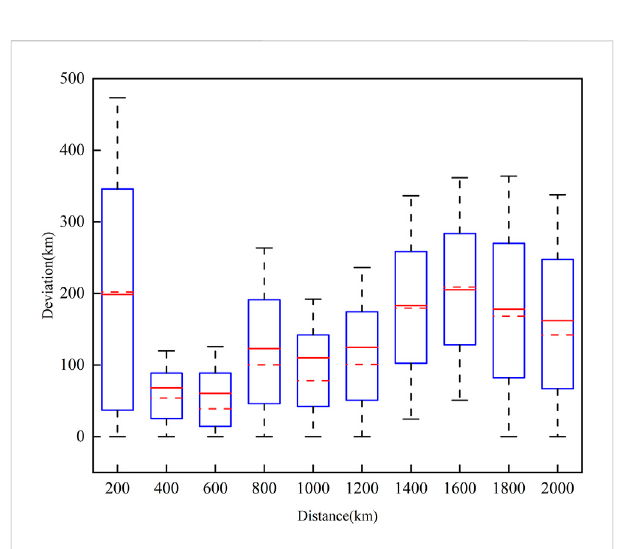
FIGURE 7 The changing trend of the deviation with